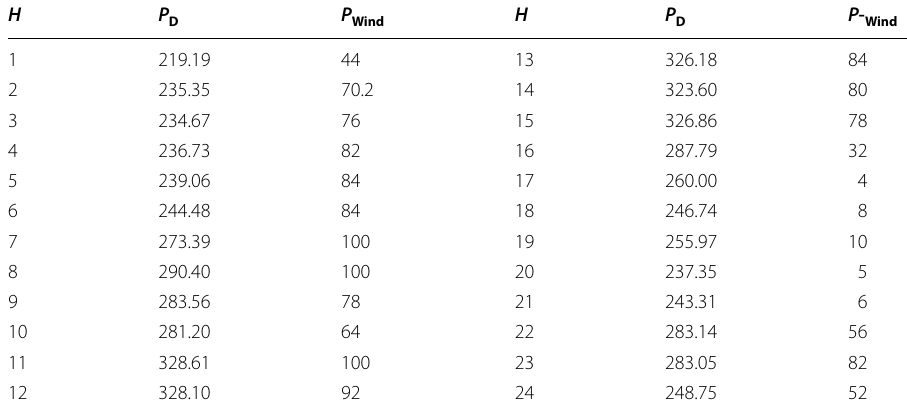
Table 3 Hourly load and forecasted wind power